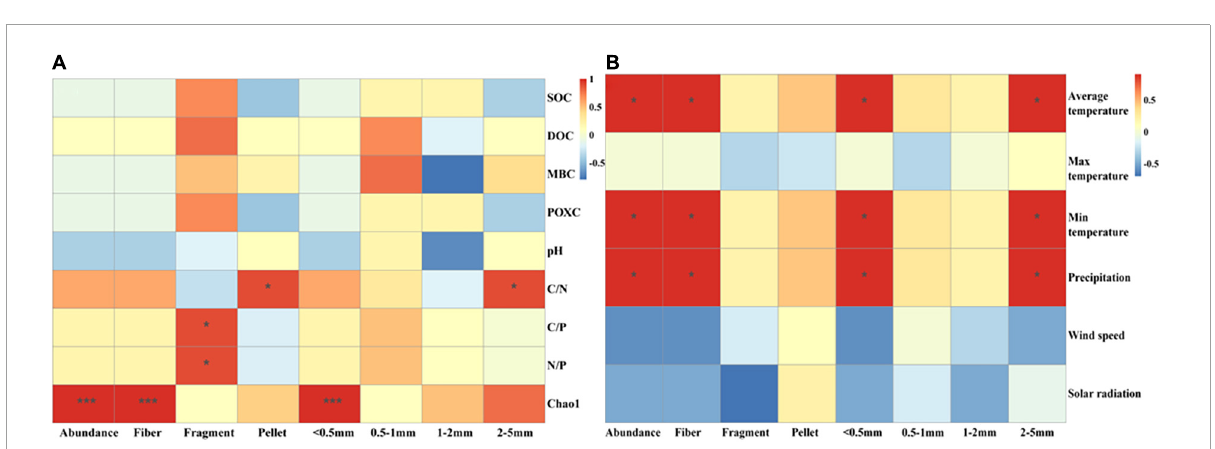
FIGURE6 Linkage of main shape and size MP abundance with soil properties (A) and meteorological factors (B) . Significant differences of paddy soils among geographic positions were indicated by * P < 0.05, ** P < 0.01, *** P <